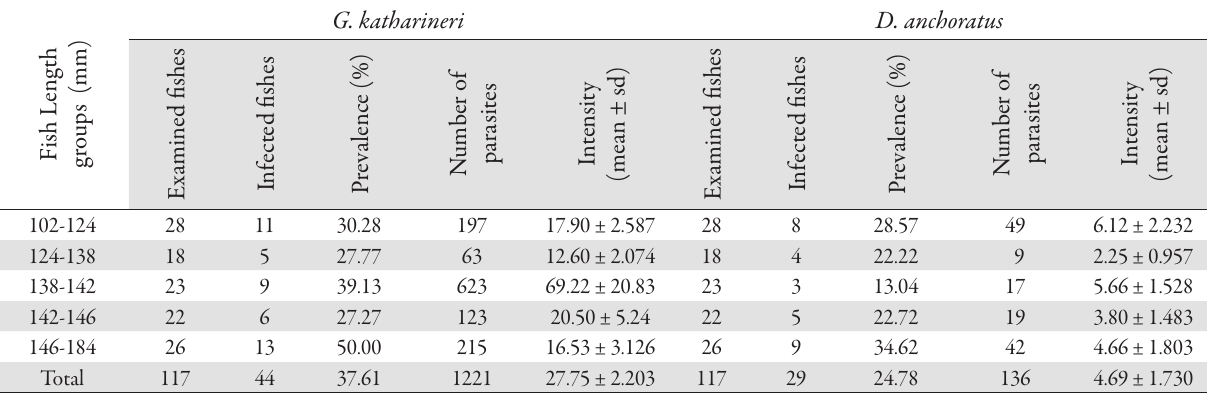
Tab. 2. Infestation prevalence (%) and mean intensity levels of G. katharineri and D. anchoratu s determined from the